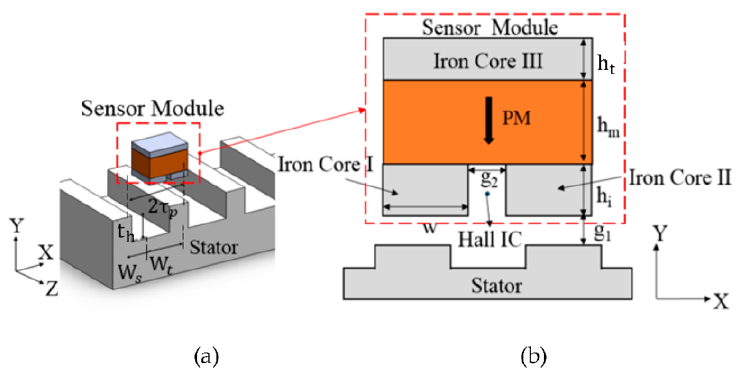
Figure 3. Linear position sensor module with the stator: ( a ) Sensor module arrangement over stator; ( b ) sensor module with different parameters.